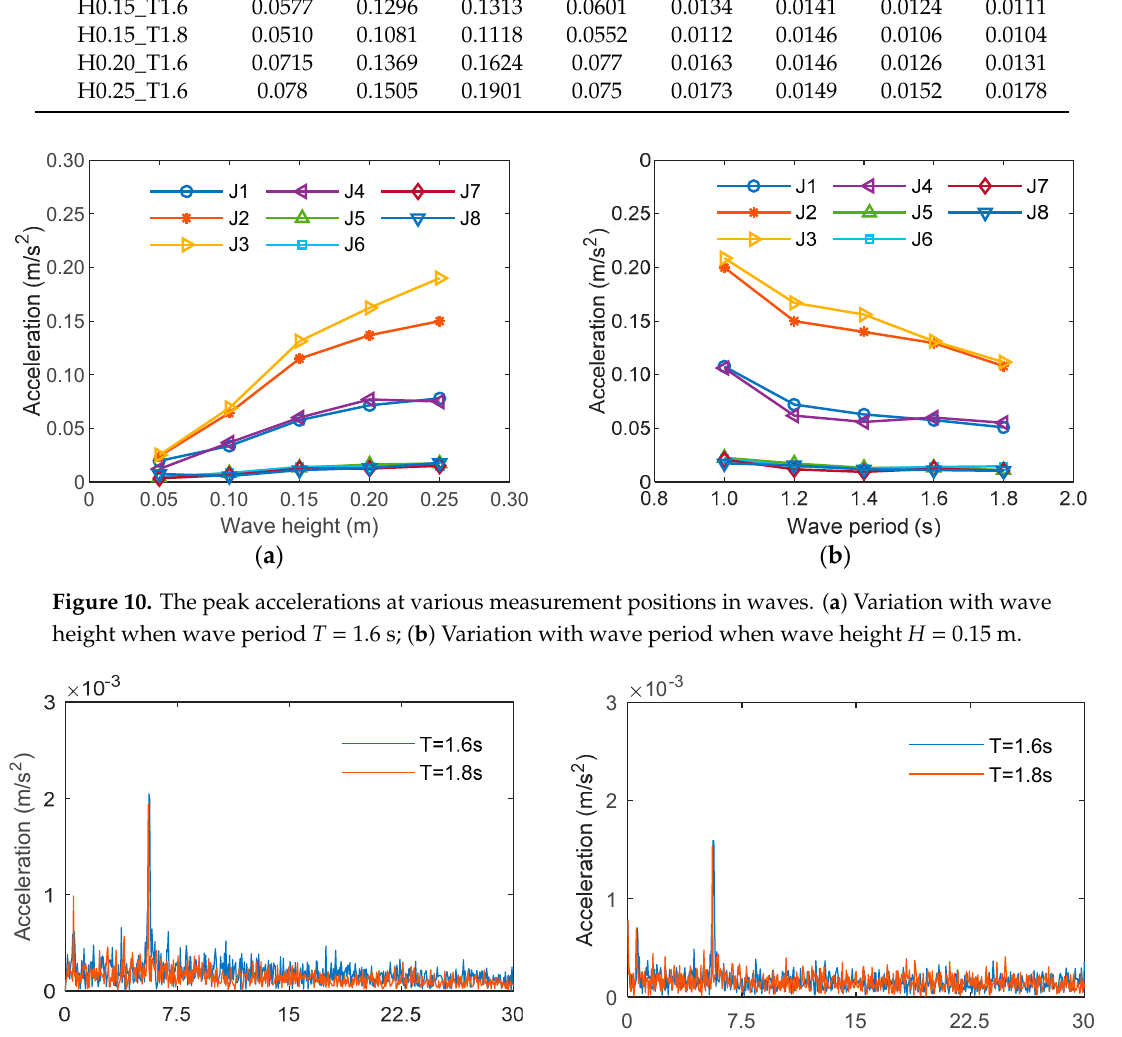
Figure 11. Frequency-domain comparison of acceleration responses at measurement positions J7 and J8 in waves. ( a ) J7; ( b ) J8.